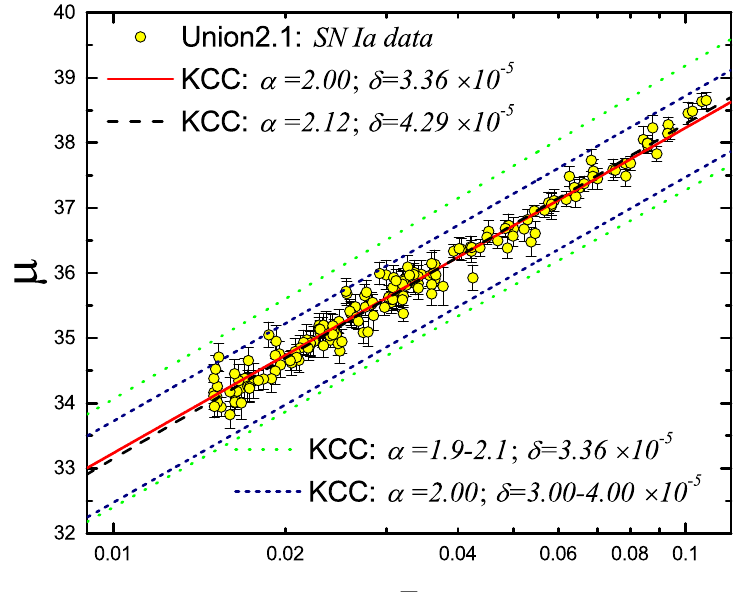
Figure 4. A subset of Union 2.1 SNIa data [35], for z (cid:46) 0 . 1 , is fitted with Equation (38). Our low-z KCC fits (red-solid curves for fixed α ; black long-dashed curves for variable α ) yield essentially the same results as in the previous fits, which used the full range of values for z . Also shown are the ranges of our KCC fitting curves, for a variable α = 1 . 9 − 2 . 1 (green-dotted curves) and for a variable δ = (3 . 00 − 4 . 00) × 10 − 5 (blue, short-dashed